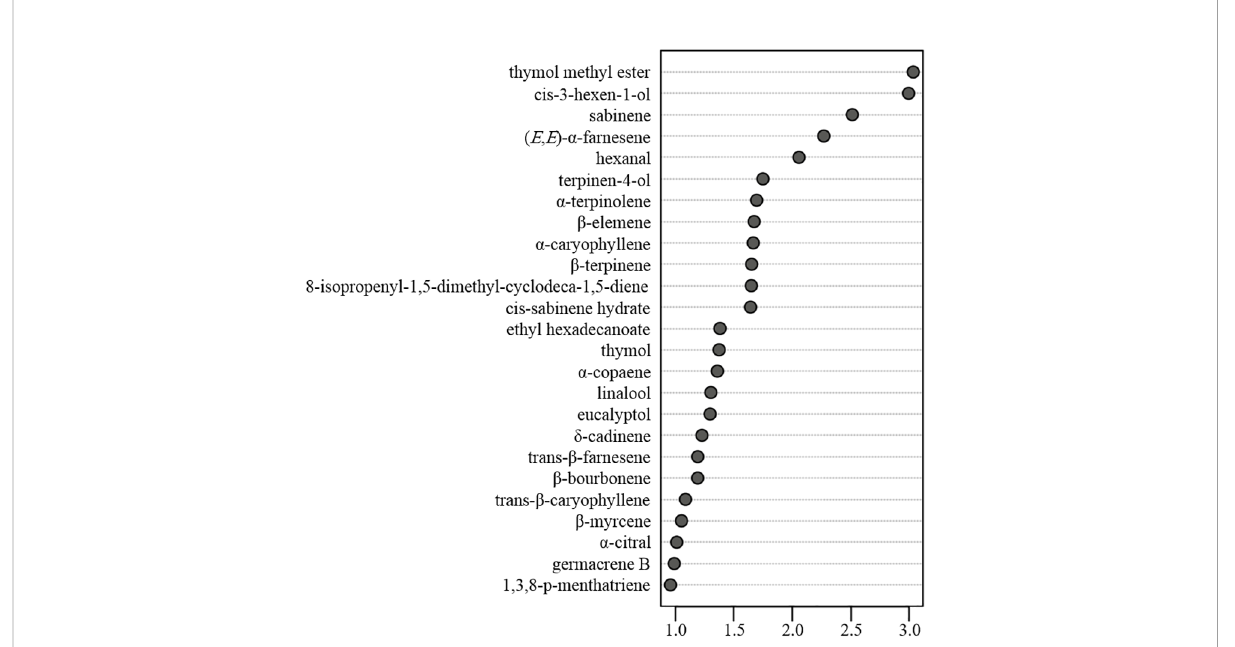
FIGURE 6 The most relevant characterized volatiles ranked by variable importance in projection